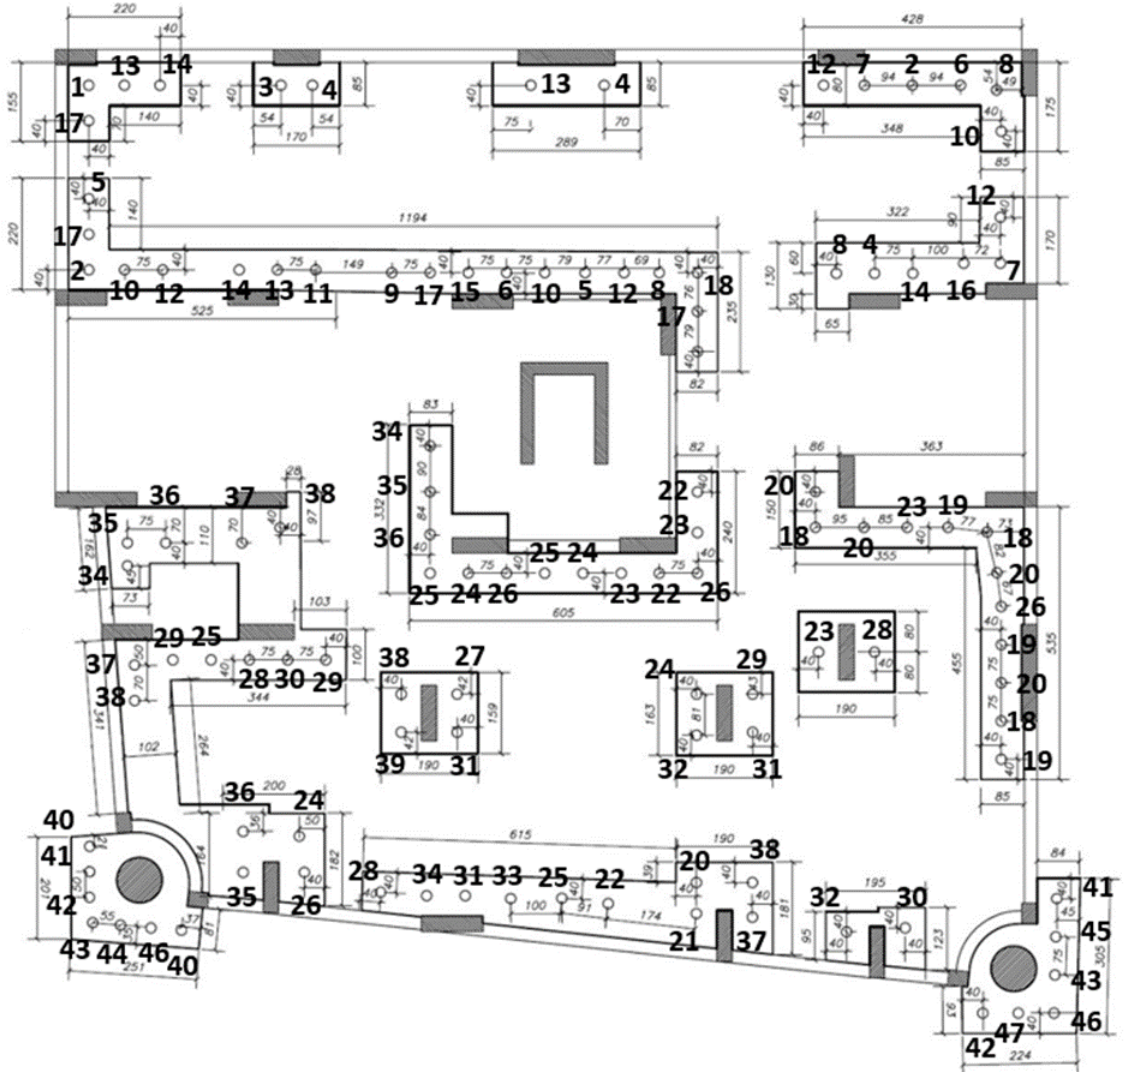
Figure 8. As-built layout of the micropiled raft (dimensions in cm), indicating the day of installation of each micropile.